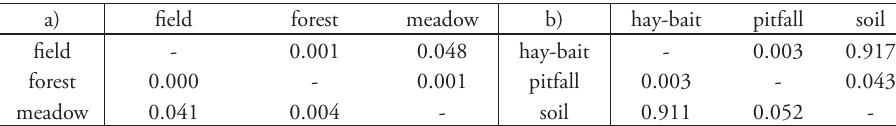
Table 2. Pairwise comparisons of species lists collected (a) at different sites and (b) by different methods. (Observed p-value below diagonal, permuted p-value above